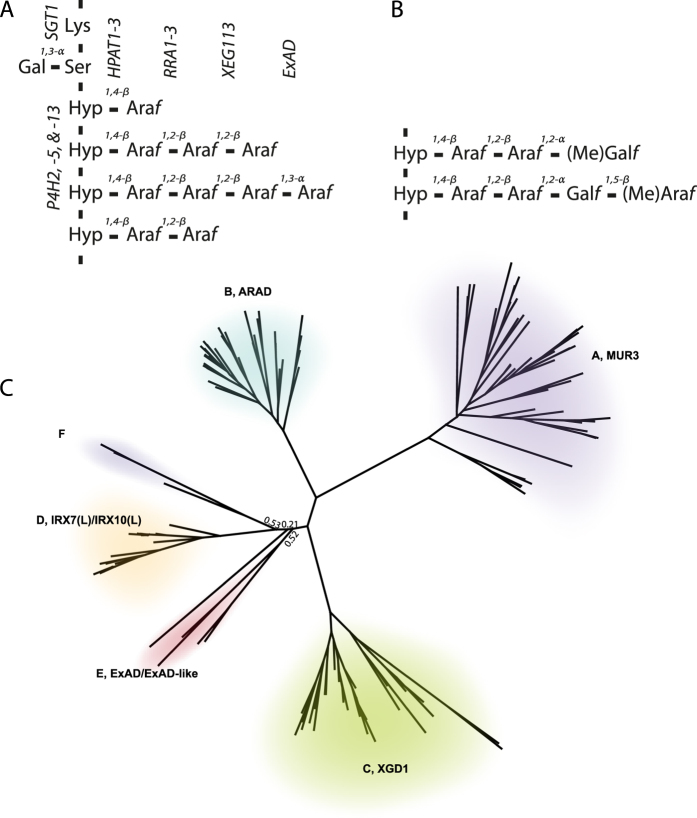
Extensin glycosylation in embryophytes and Chlamydomonas reinhardtii (chlorophyte).(A) Canonical extensin repeat structures and extensin glycosylation enzymes. In the classic extensin repeat motif, SP3–5910, serine is substituted with an α-1,3 linked galactose and the hydroxyprolines (Hyps) are substituted with β- and α-linked arabinofuranoses (Araf) of lengths from 1 to 5 in terrestrial plants and CGAs. Genes encoding GTs involved in building the structures are indicated. (B) The innermost two Arafs also exist in the chlorophyte alga C. reinhardtii, where they are extended by an α-1,2-galactofuranose (α-1,2Galf) and a β-1,5Araf, which may additionally be methylated at either the C-6 or C-3 position, respectively9. (C) Clade structure of family GT47. The tree was built from Arabidopsis thaliana (At), Physcomitrella patens (Pp), Selaginella moellendorffii (Sm), Oryza sativa (Os) and Klebsormidium flaccidum. The corresponding Newark tree file, GT47tree.txt, is provided as Supplementary Data. No known function has been demonstrated for members of the F-clade; GTs with known function, in the other clades are indicated (MUR361, ARAD62, XGD163, IRX7/IRX16465).